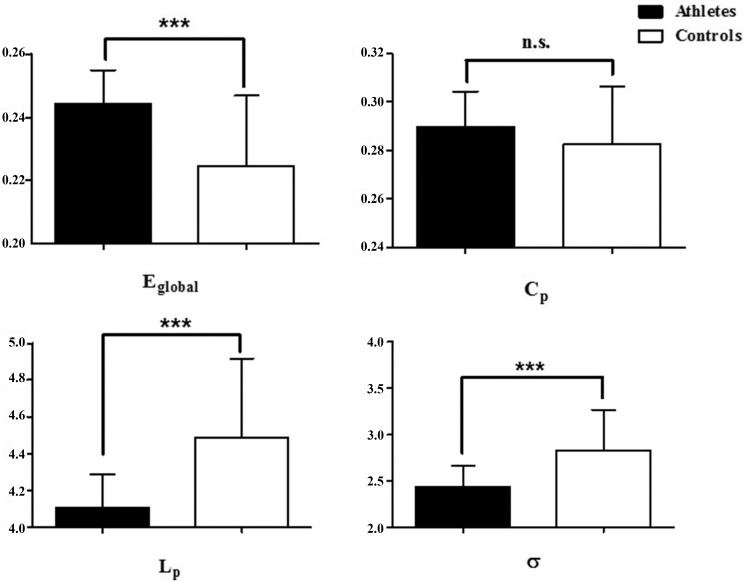
Comparison of global parameters between the athlete group and control group.Black indicates the athlete group while white indicates the control group. The brain network of the athlete group had a higher global efficiency and a lower shortest path coefficient and small-worldness.